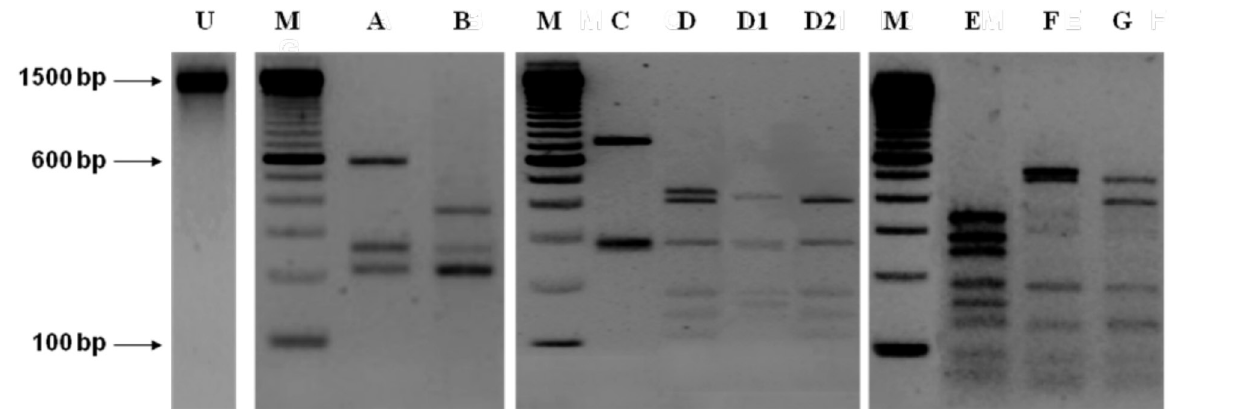
Figure 4. Restriction fragment length polymorphism patterns of Burkholderia gladioli and unidentified strains iso- lated from saffron after digestion of PCR amplification products obtained with fD1 and rD1 primers with the restric- tion endonucleases Alu I (A and B), Dde I (C, D, D1 and D2) and BssK I (E, F and G). M = 100 bp ladder (Invitrogen); U = uncut product; (B, D, F) = B. gladioli pv. gladioli CFBP 2427; (B, D, F) = Group B isolates; (B, D2, F) = B. gladioli pv. alliicola CFBP 2422; (A, D1, F) = B. glumae CFBP 2430; (B, D, G) = B. gladioli pv. agaricicola CFBP 3580; (B,